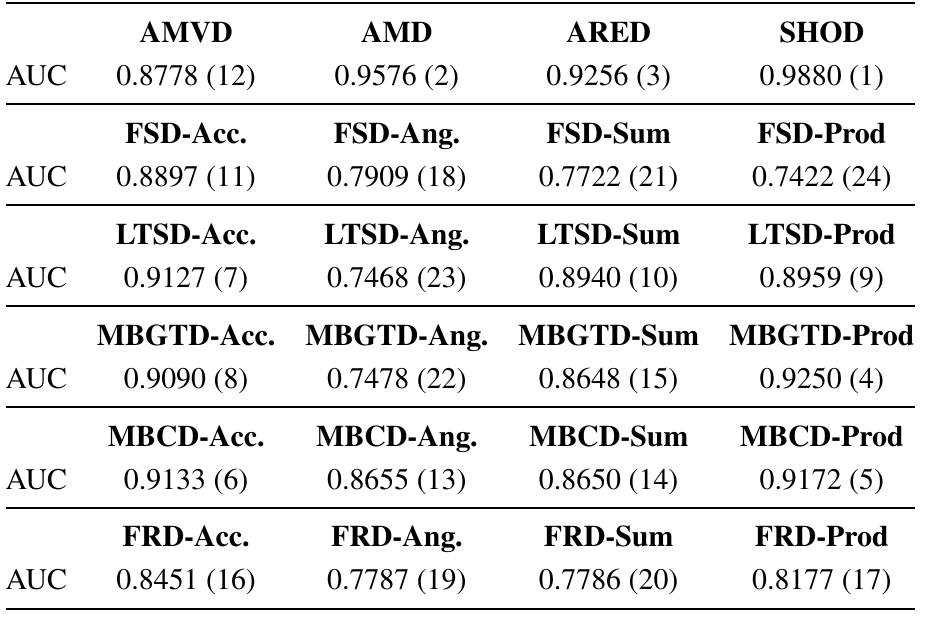
Table 13. Area Under Curve (AUC) computed out of ROC curves obtained from application of algorithms on synthesized signals. Number in brackets indicates overall position in performance comparison.